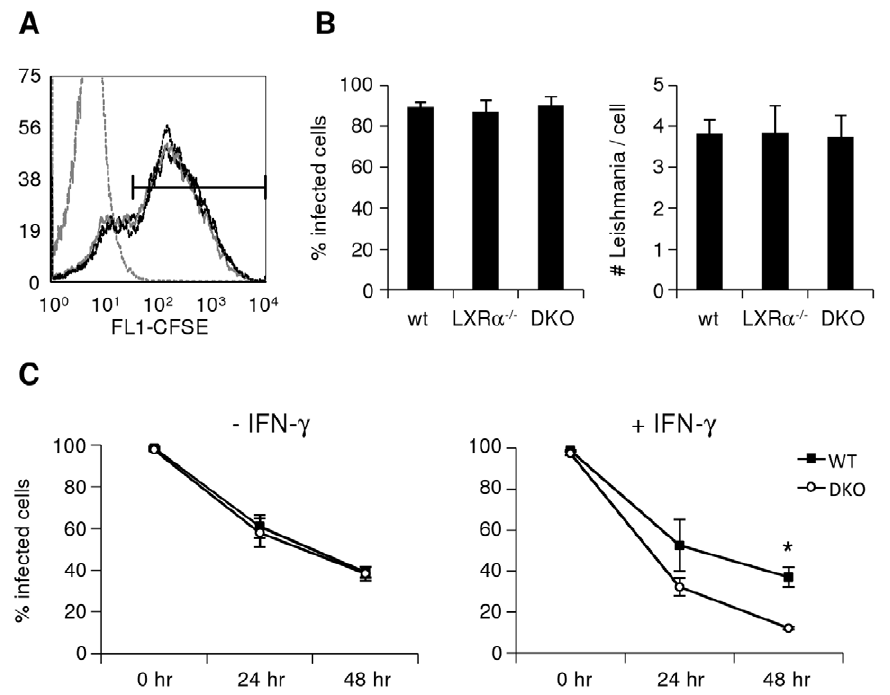
Figure 2. LXR-deficient macrophages are infected similarly, but kill Leishmania more efficiently than wild-type macrophages treated with IFN- c . Bone marrow-derived macrophages (BMDM) were infected with stationary-phase, (A) CFSE-labeled or (B) unlabelled L. chagasi/ infantum at an MOI of 10:1 for 1 hour, and 2 hours later percentages of infected cells (CFSE-positive events) were determined by (A) flow cytometry (WT uninfected = gray dotted line; WT infected = black solid line; LXR a 2 / 2 infected = gray solid line; LXR-DKO infected = black dotted line) or (B) microscopy (the number of parasites per cell was also assessed by microscopy). C. BMDM were infected with stationary-phase, unlabelled L. chagasi/ infantum at an MOI of 20:1 for 2 hours in the presence or absence of IFN- c (overnight pretreatment), and immediately, 24, or 48 hours later were Giemsa-stained for microscopic quantitation of numbers of amastigotes per cell. Similar results were found in least 3 independent experiments; error bars represent standard error; * denotes p ,